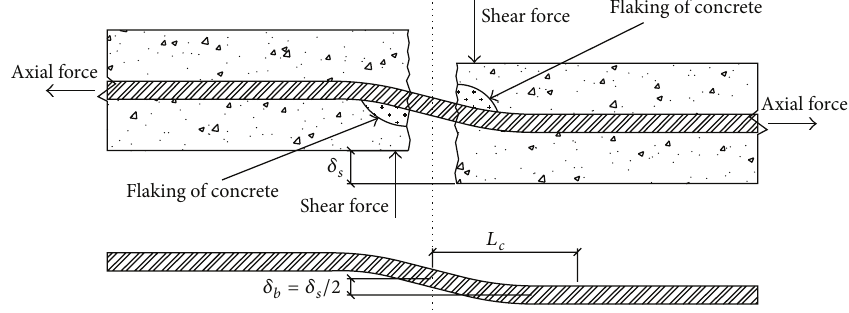
Figure 3: The bending of connecting steel bar under joint interface slip.